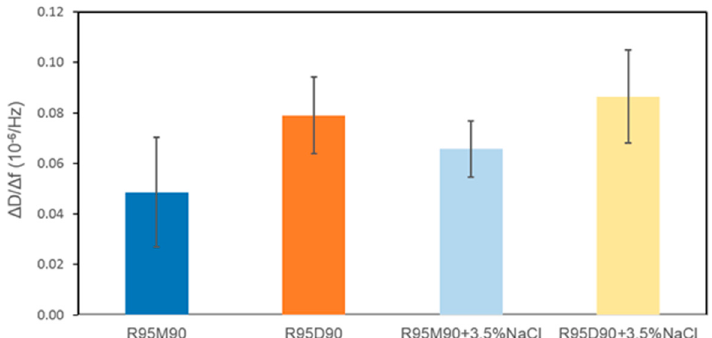
Figure 7. Equilibrium ∆ D / ∆ f values of 0.15 wt.% R95M90 and R95D90 adsorbed layers on gold surfaces from water and 3.5 wt.% NaCl aqueous solution.